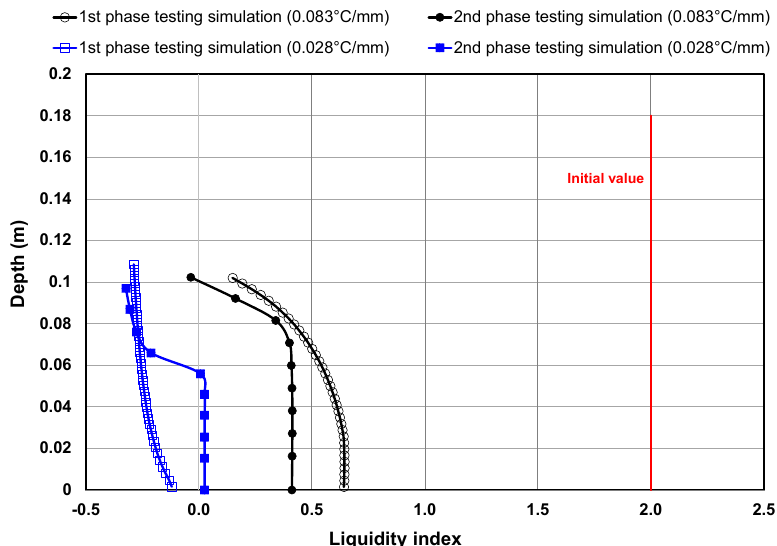
Figure 12. Liquidity index profiles of centrifuged tailings from coupled analysis.